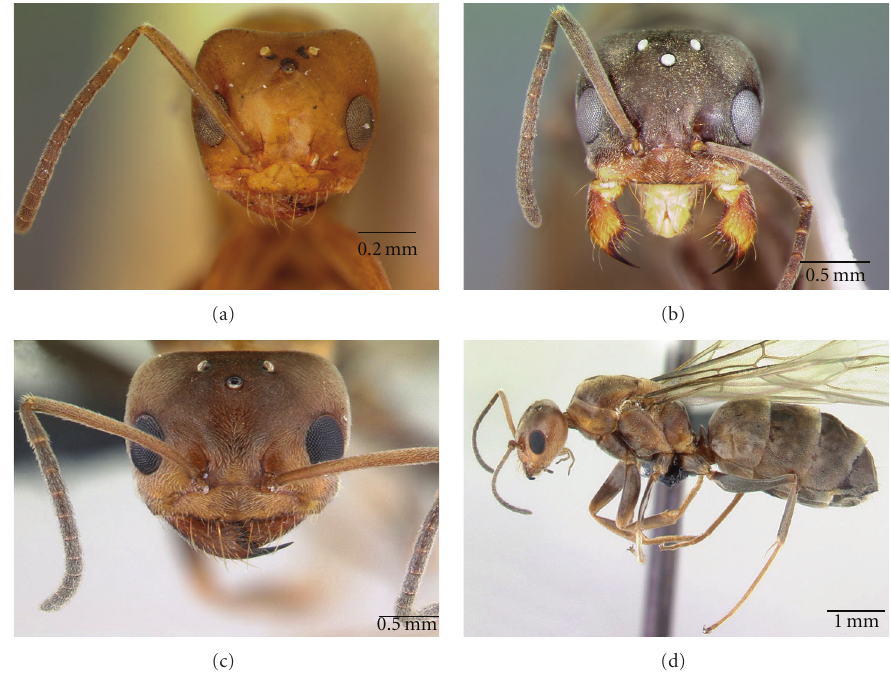
Figure 6: Queens of three Dorymyrmex species. (a) and (b) Heads of (a) Dorymyrmex bicolor ; (b) Dorymyrmex brunneus ; (c)-(d) Dorymyrmex biconis : (c) head and (d) body profile